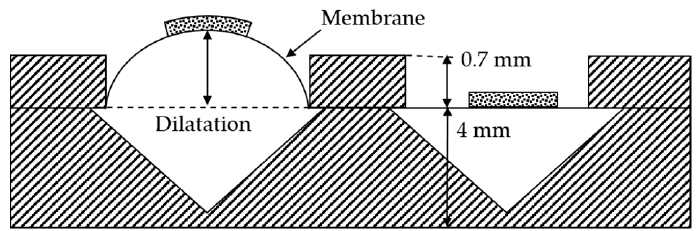
Figure 4. Schematic cross-section of the module in which the left chamber is pressured.